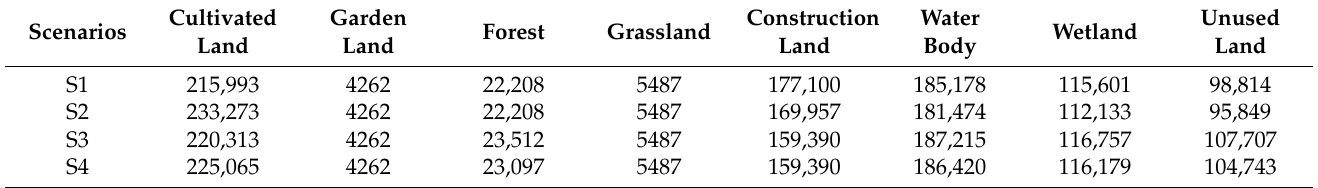
Table 3. Predicted area of land use types in four planning scenarios in Dongying City in 2030 units:hm 2 .